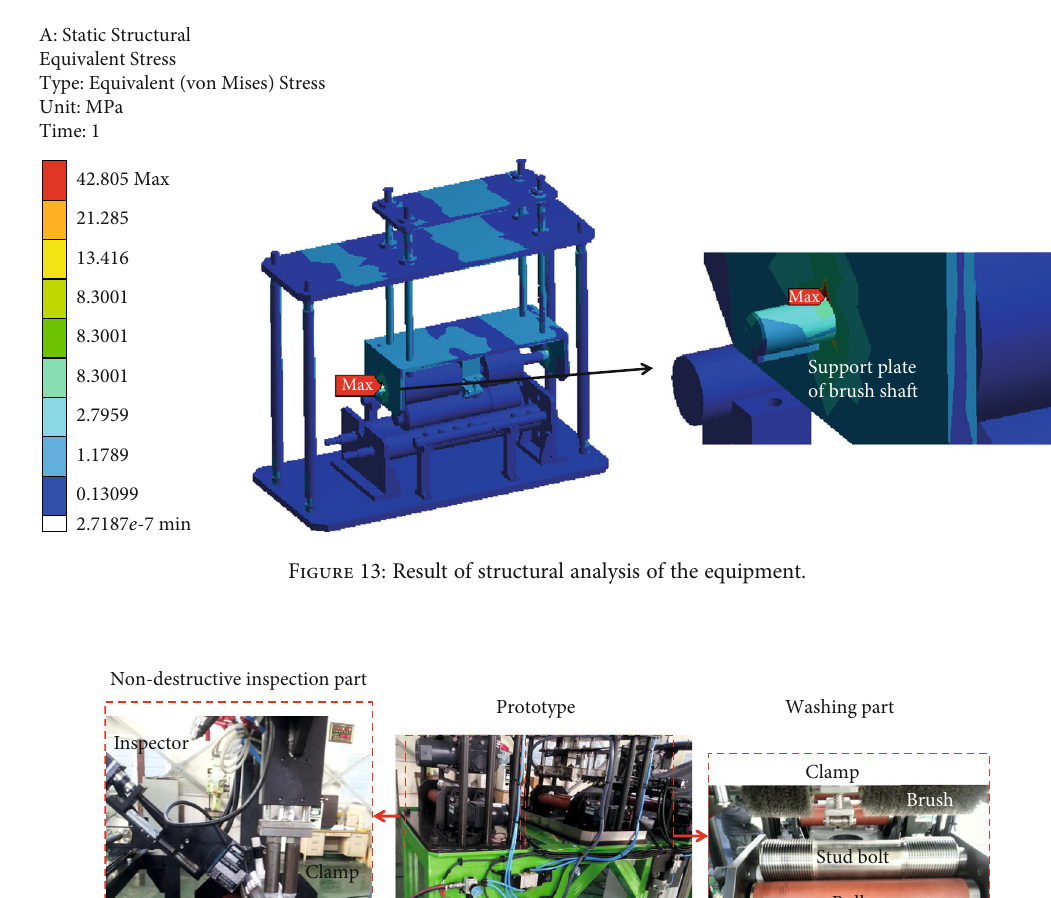
Table 3: Orthogonal array ( L